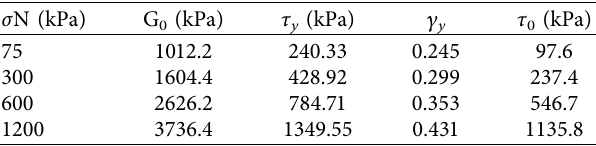
Table 1: Mechanical properties of the TFPU-bentonite contact